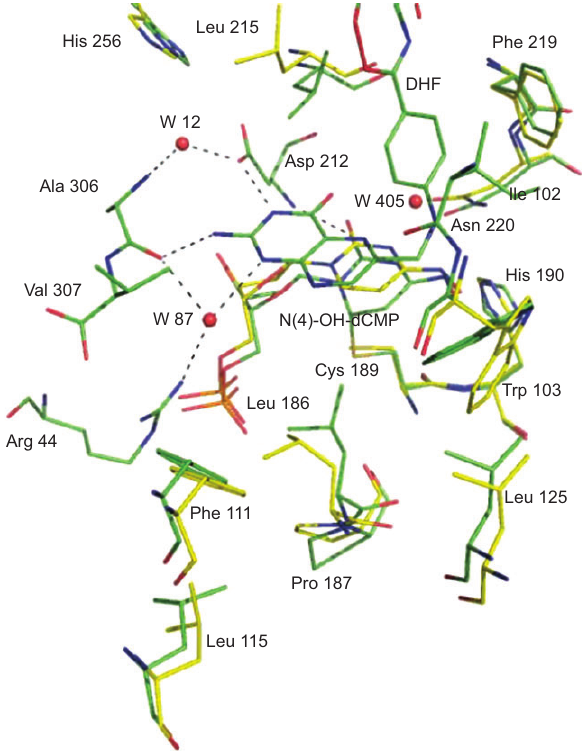
Figure 5 The active site of the mTS-N 4 -OH-dCMP-DHF complex (residues colored in green). Selected residues from the superim- posed mTS-N 4 -OH-dCMP complex and the N 4 -OH-dCMP molecule are colored yellow. Selected water molecules are shown as red balls.